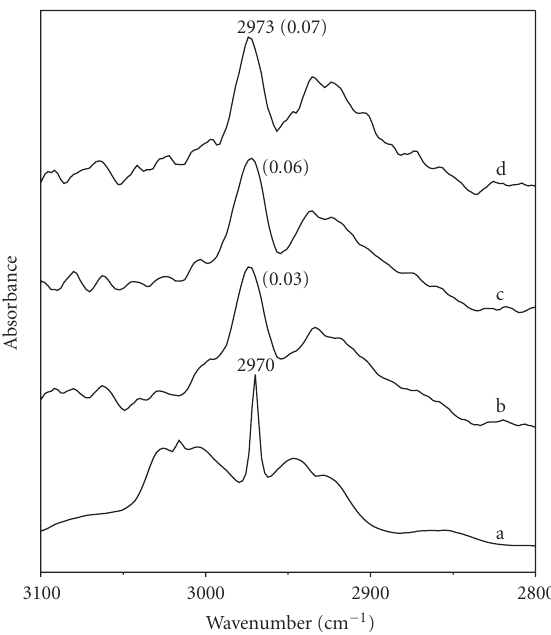
Figure 10: C–H stretching region infrared spectra of sample H3 (hydrothermally synthesized Au/TiO 2 ), exposed to 0.2 μ mol of ace- tone vapor and recorded after the lapse of 10 minutes (curve (b)) and subsequent heating at 320 K (curve (c)) and 360 K (curve (d)). Curve (a) shows corresponding vibrational bands of acetone vapor. The numbers given in the parentheses indicate the absorbance value of the particular IR band. Figure 11: Stretching C = O, C = C, C–C, and deformation CH re-